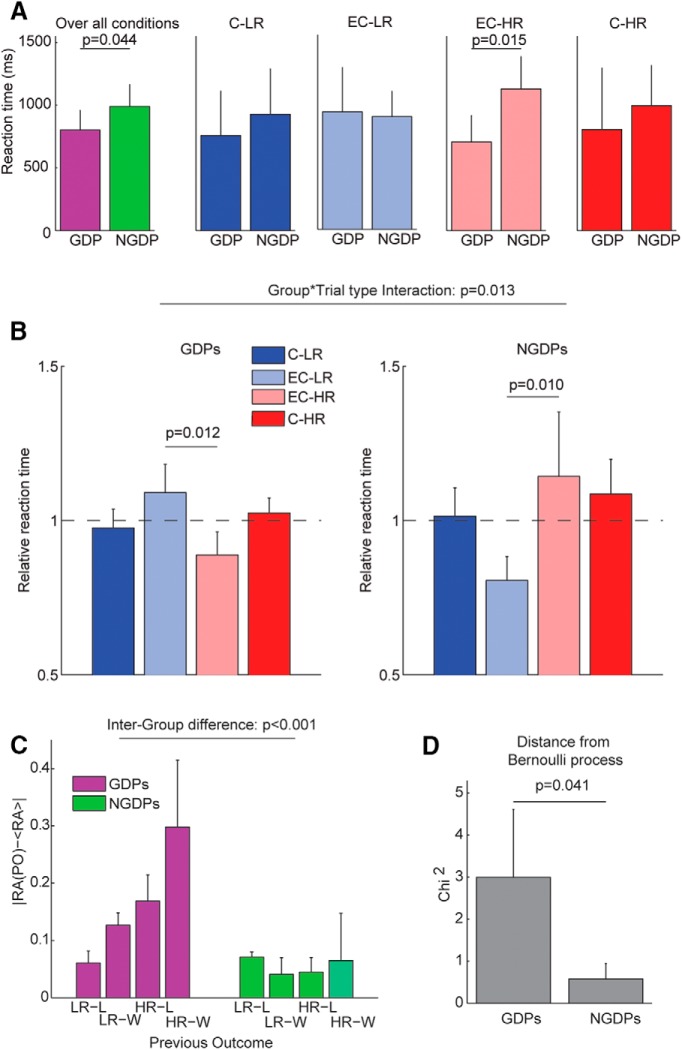
Risk avoidance bias precedes options presentation. A, Comparison of reaction times in GDP (n = 6) and NGDP (n = 6). From left to right: over all conditions, low-risk choice in conflictual (C-LR) and equivalent choice (EC-LR) trials, high-risk choice in equivalent choice (EC-HR) and conflictual (C-HR) trials. B, Relative reaction times (RT) for the different conditions pooling all sessions of each patient group. The dashed line indicates the median RT. C, Modulation of risk aversion due to previous outcome (PO) for GDPs (purple) and NGDPs (green). D, χ2 discrepancy between observed responses and expected responses in an equivalent memoryless Bernoulli process for GDPs (n = 6) and NGDPs (n = 6). Bars and error bars represent median and median confidence interval, respectively, for all panels. Horizontal line inserts highlight significant differences reporting p value (see Results for details) for all panels.